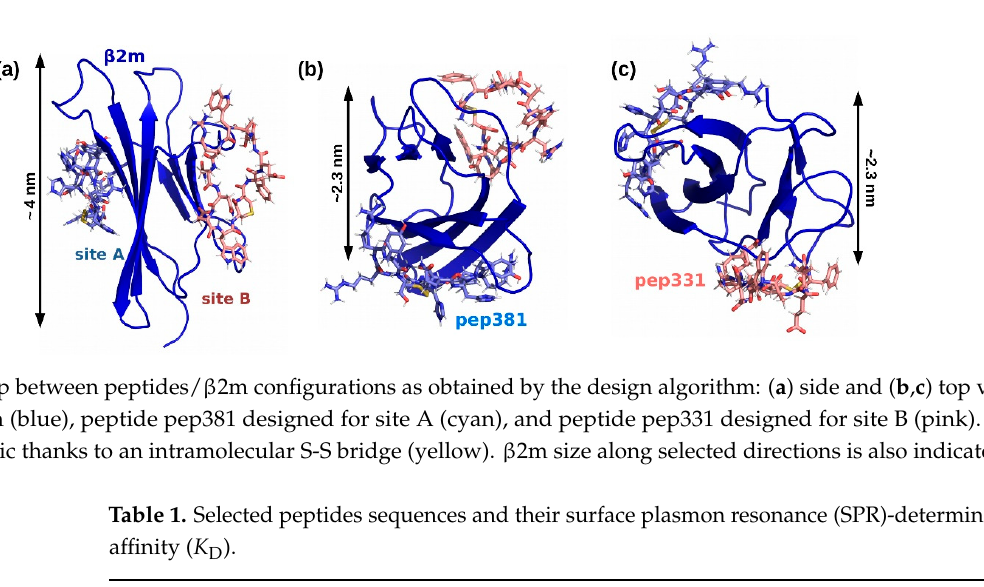
Table 1. Selected peptides sequences and their surface plasmon resonance (SPR)-determined